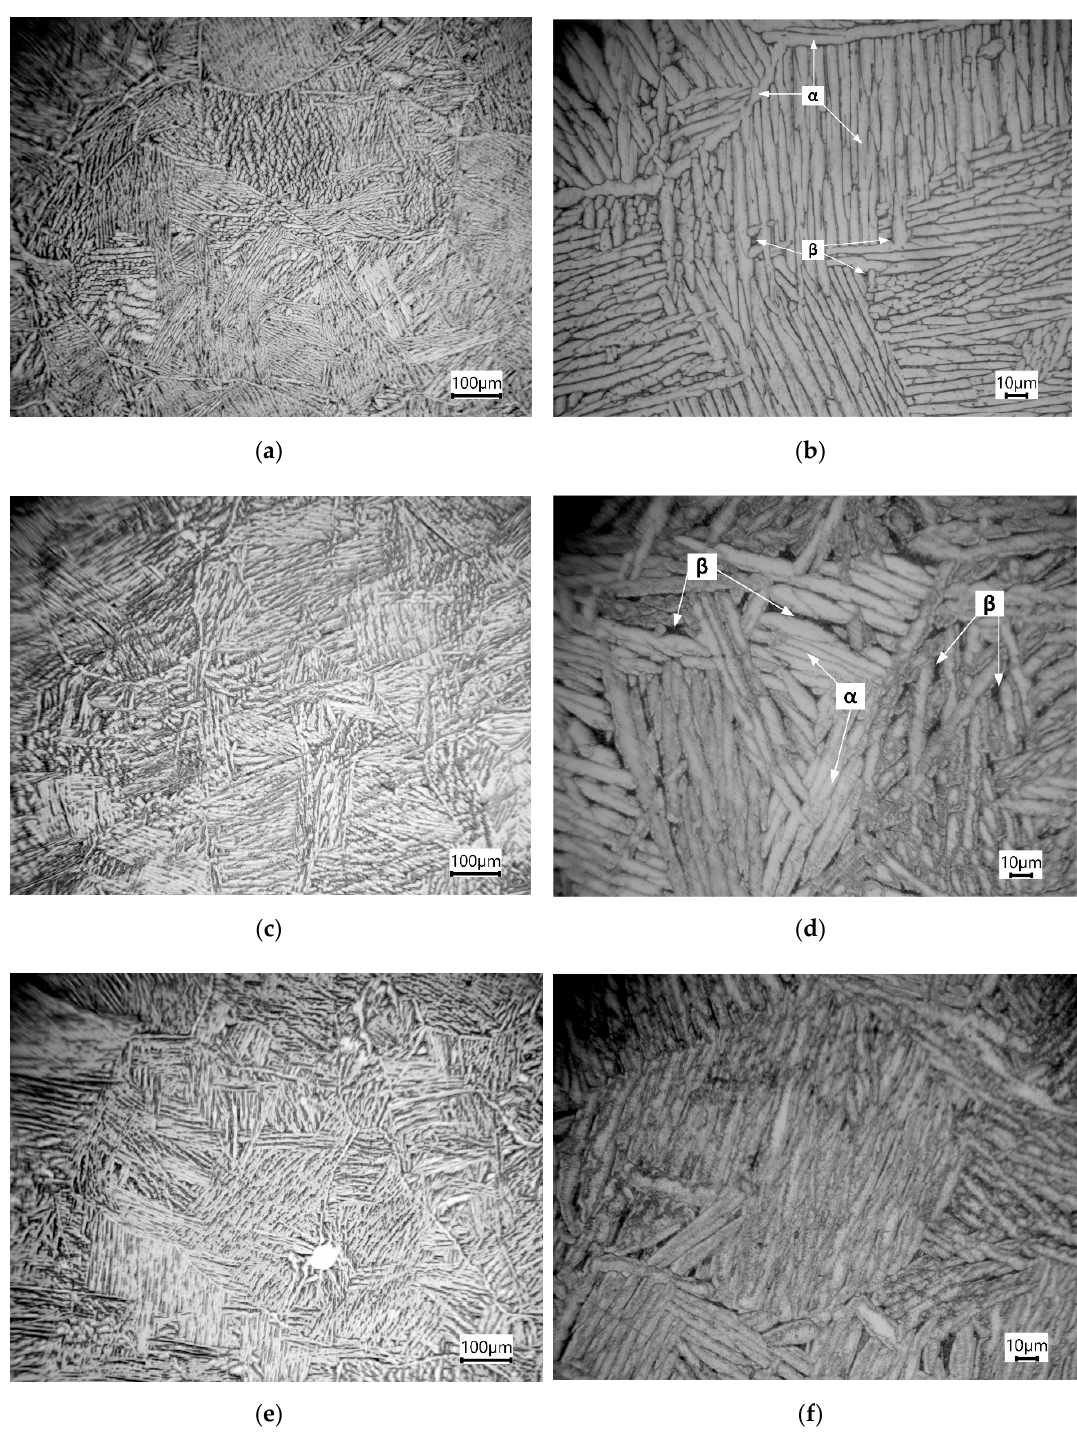
Figure 8. Microstructure of sample no. 2, the «perpendicular» technique: ( a , b ) Direction 1 according to Figure 5b; ( c , d ) direction 2; ( e , f ) direction 3.